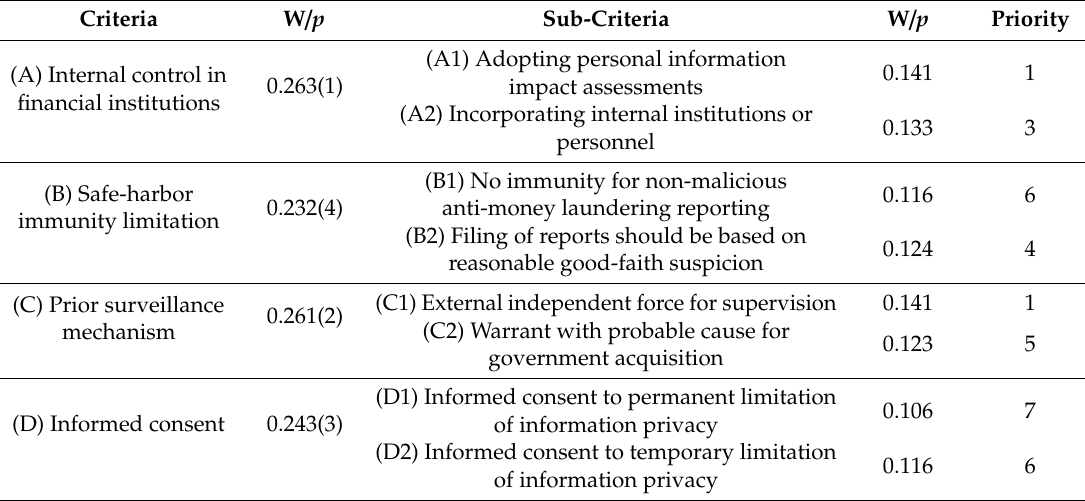
Table 5. Comparative weights between the criteria and